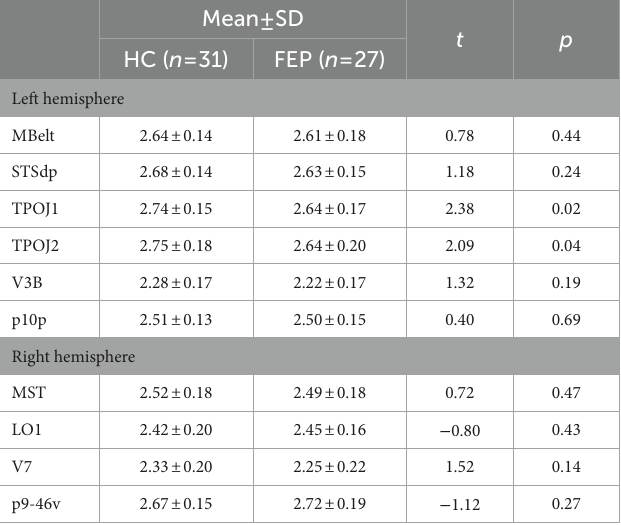
TABLE 4 Gray matter thickness.